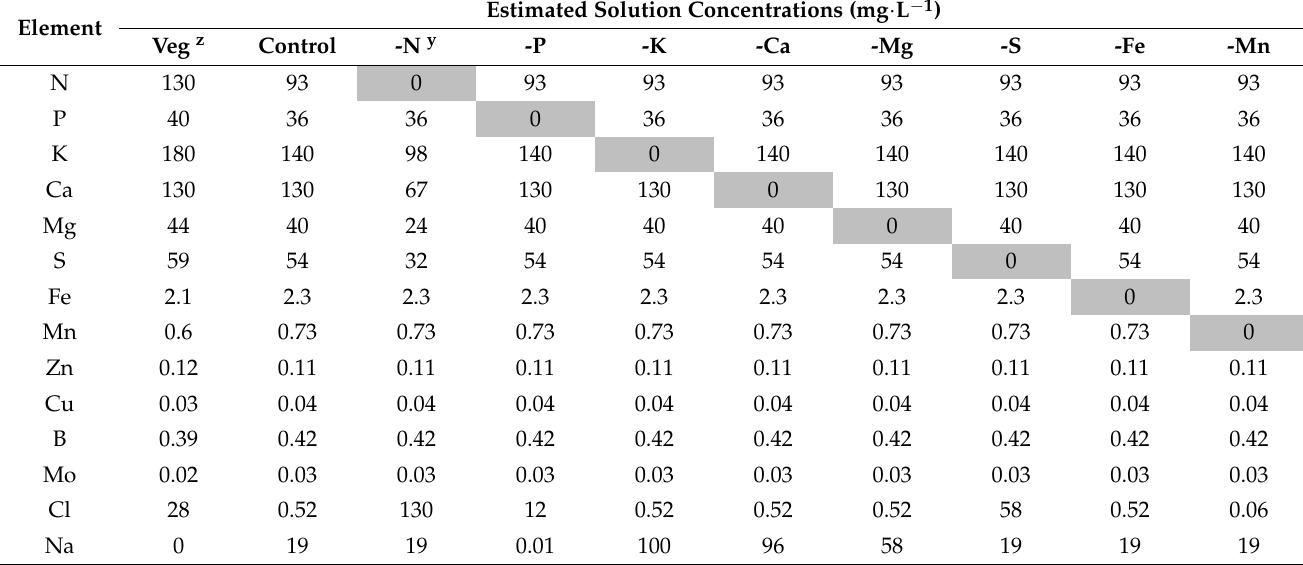
Table 1. The calculated solution concentrations (mg · L − 1 ) of nutrient elements (plus Na) in the vegetative-stage nutrient solution and each of the nutrient deficiency treatments. Shaded cells highlight the elemental concentrations of the deficient nutrient in the respective treatments.